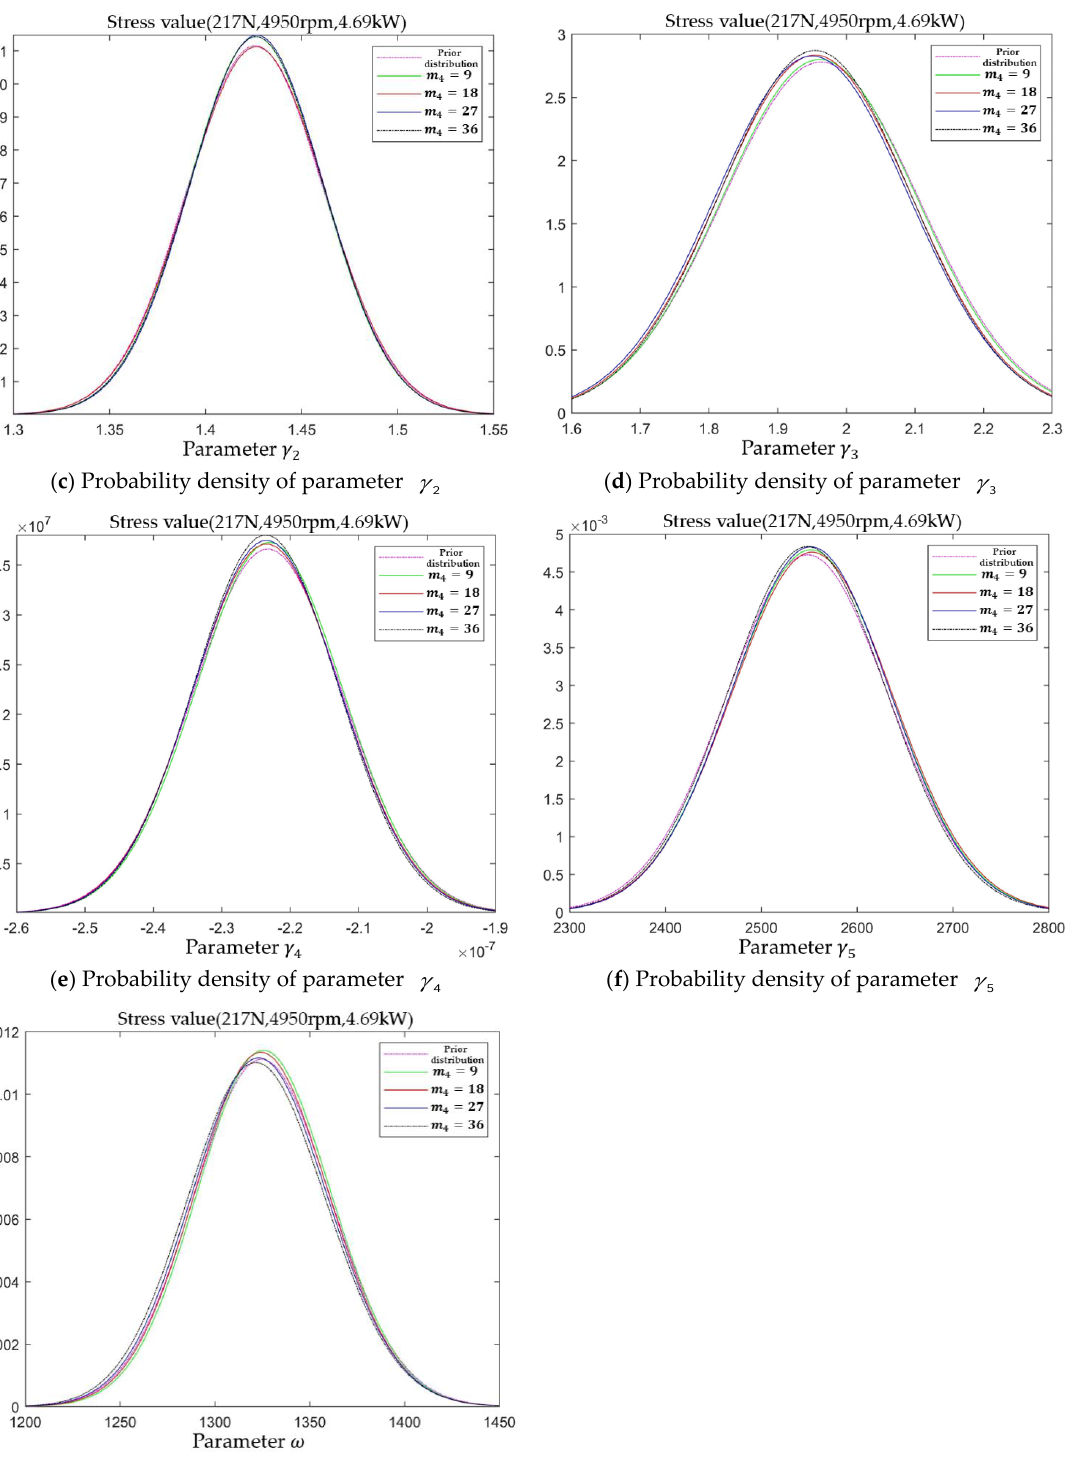
Figure 10. The update process of probability density of each model parameter with the test ( l = 4). In Figure 12 there is a significant change between the posterior distribution probability density functions of parameters γ 0 , γ 2 , γ 3 and γ 4 the prior probability density functions, where γ 0 , γ 2 and γ 4 are variance fluctuations and γ 3 is the mean shift. In particular, the posterior distribution of parameter γ 0 at the previous two stress levels has converged